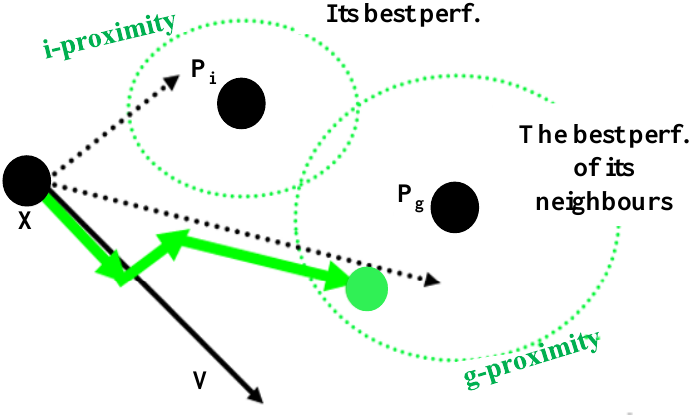
Figure 1. The velocity motions of particles in PSO.